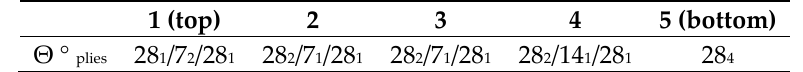
Table 1. The optimal layup orientation for the four plies in each partitioning of the centerboard.